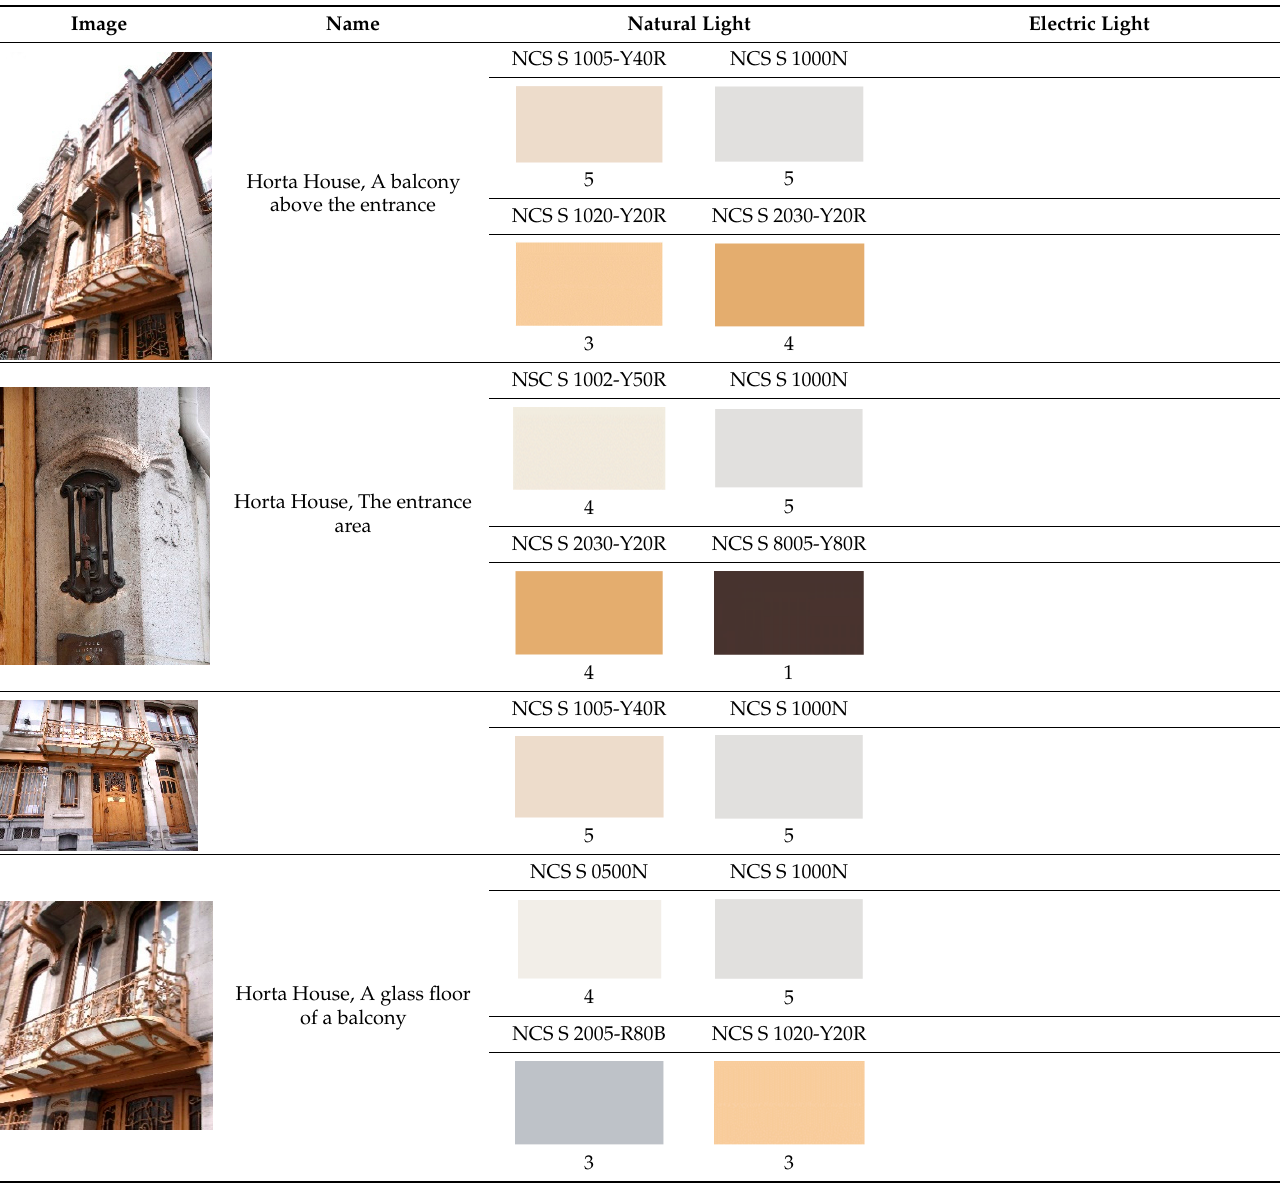
Table A5. The colors of the interiors of the examined buildings designed by Victor Horta.